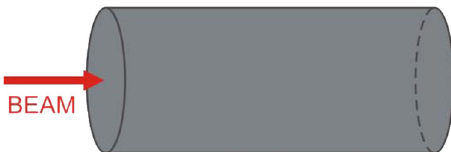
FIG. 8. (Color) Geometrical model of the bulky-target irradia-